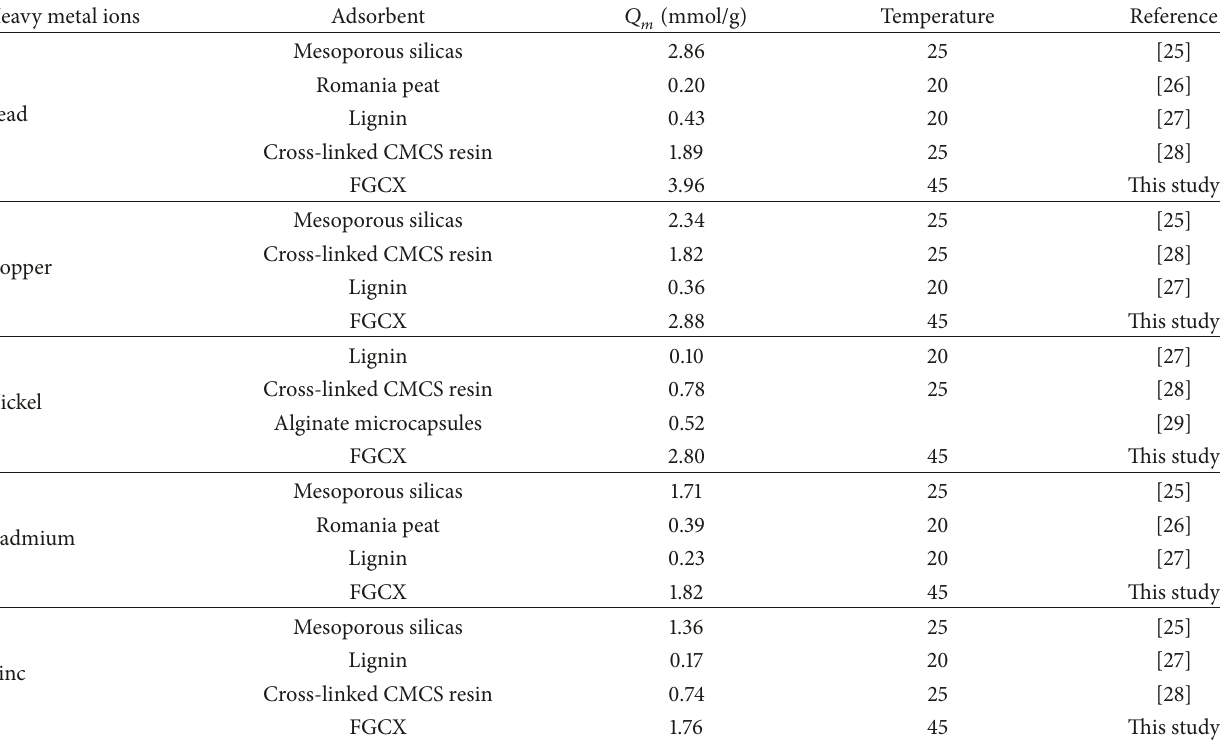
Table 2: Comparison of adsorption capacity of FGCX onto Pb, Cu, Ni, Cd, and Zn with other